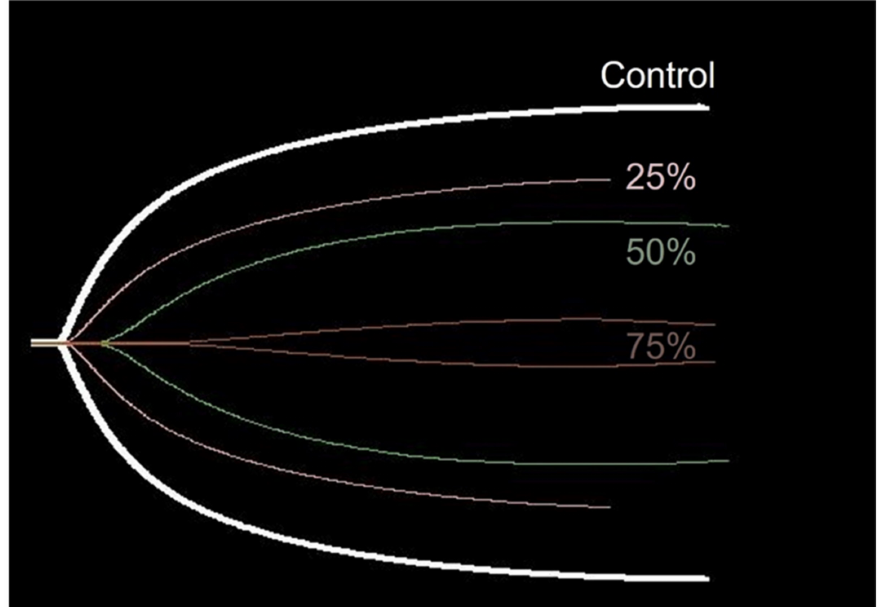
Figure 4. Typical TEG trace lines suggesting concentration-dependent changes from one of the dogs. The trace lines of the control and different venom concentrations (% LD50 iv ) are placed on the similar central axis for an easier comparison.